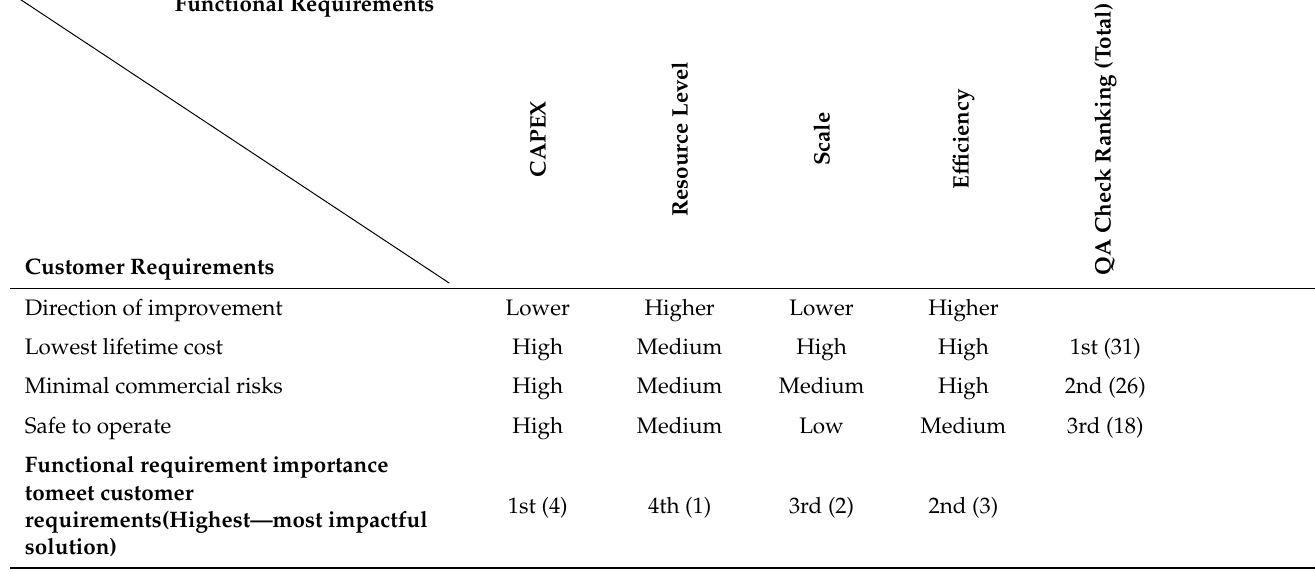
Table 4. Wave energy concept example of defined functional requirements and